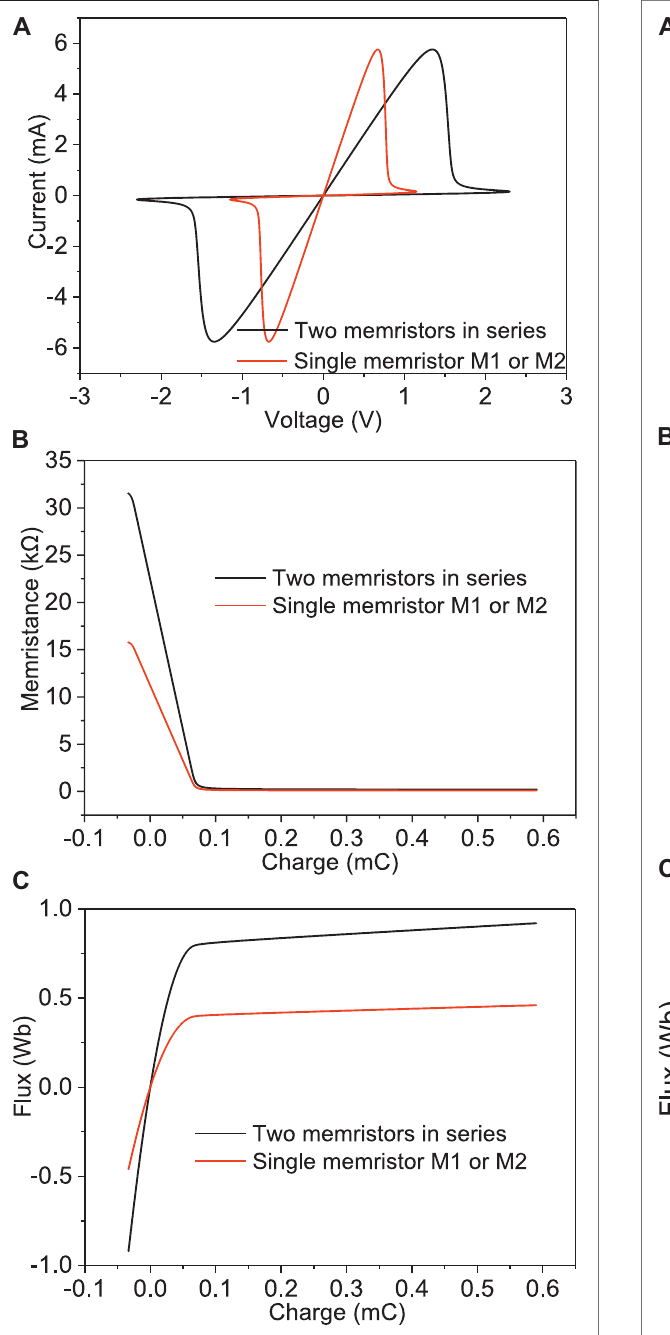
FIGURE10|(A) Current versusvoltage curves, (B) memristance versus charge curves, and (C) fl ux versus charge curves of the single memristor and two memristors in series with opposite polarities.